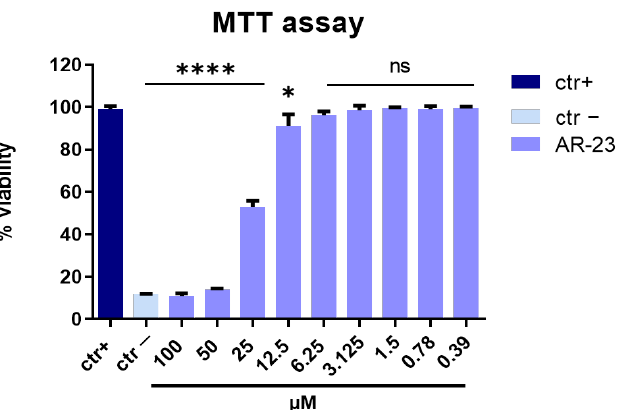
Figure 1. Cytotoxic activity. Cell viability evaluation by MTT assay of Vero cells after treatment with AR-23 for 24 h at several concentrations (from 100 to 0.39 μM). Not treated cells were used as positive control (ctr+), while DMSO was used as negative control (ctr-). **** p < 0.0001; * p < 0.0280; ns: non-significant.